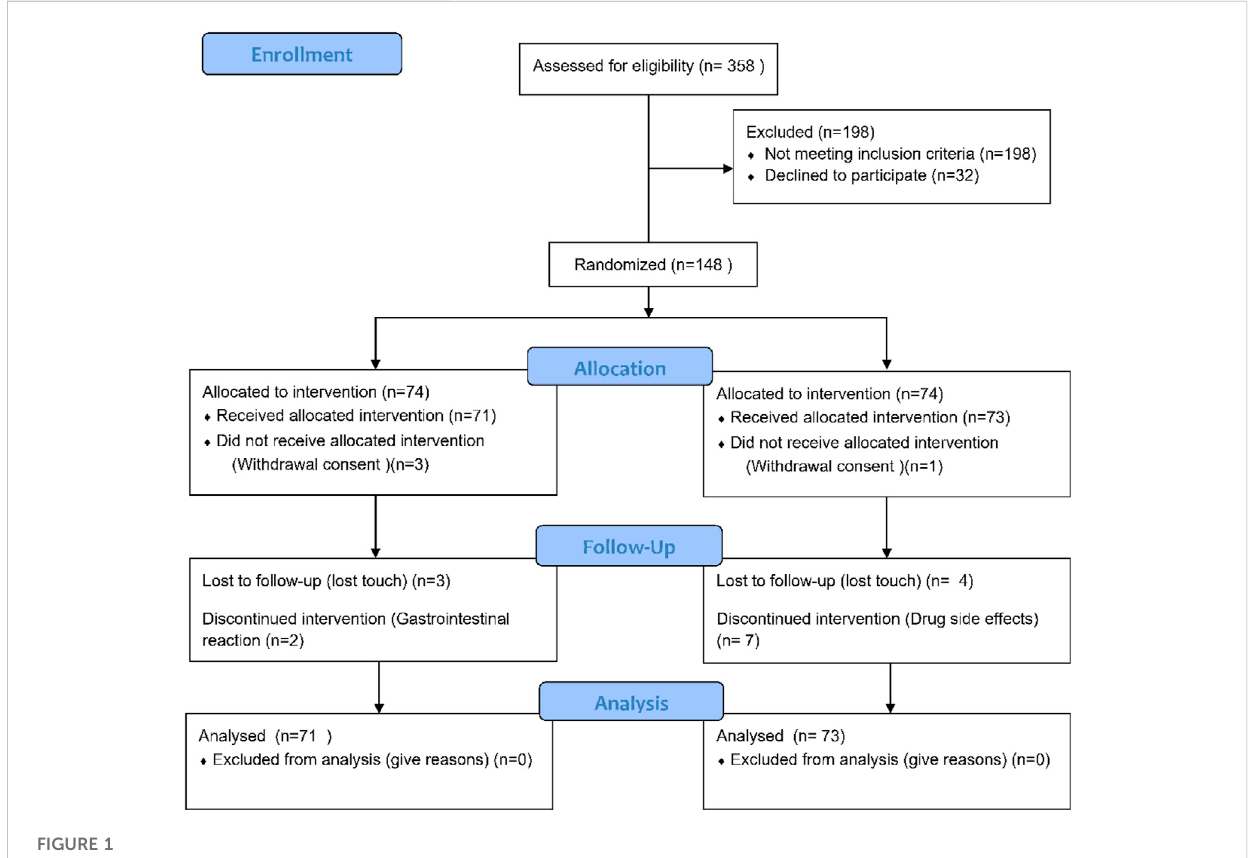
FIGURE 1 CONSORT fl ow